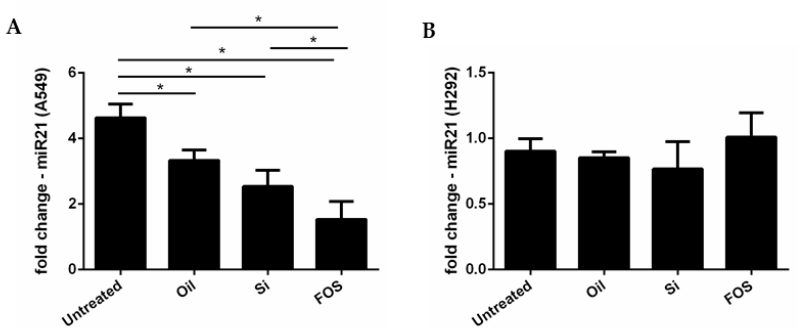
Figure 4. Effects of FOS in miRNA-21 gene expression. A549 ( A ) and H292 ( B ) were treated with oil, silica, and FOS for 24 h, and miRNA-21 expression was assessed by real-time PCR. Results are expressed as mean ± SD (n = 3). The comparison between different experimental conditions was evaluated by ANOVA corrected with Fisher’s test. * p < 0.05 was accepted as statistically significant.